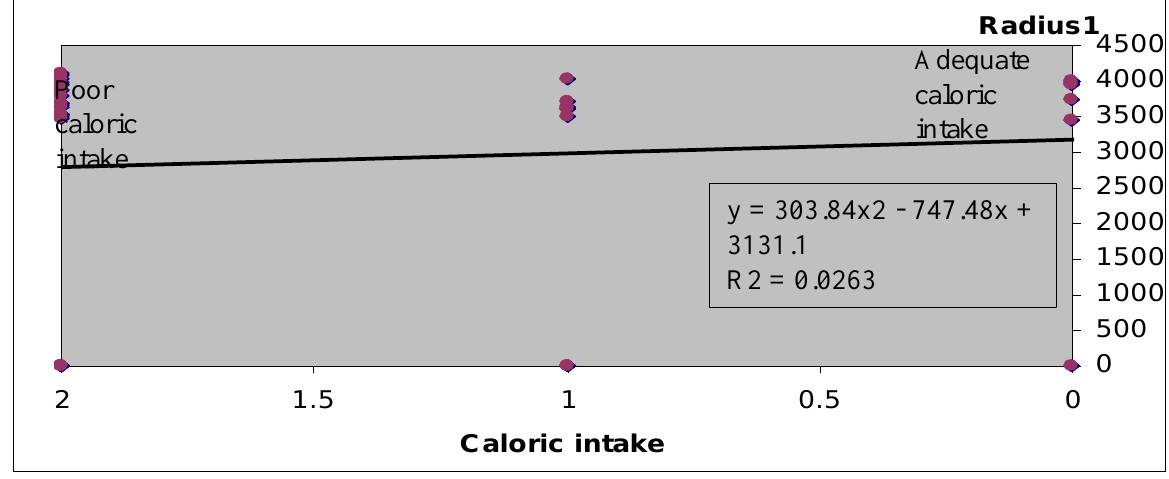
FIGURE 4. The connection between caloric intake and bone strength.